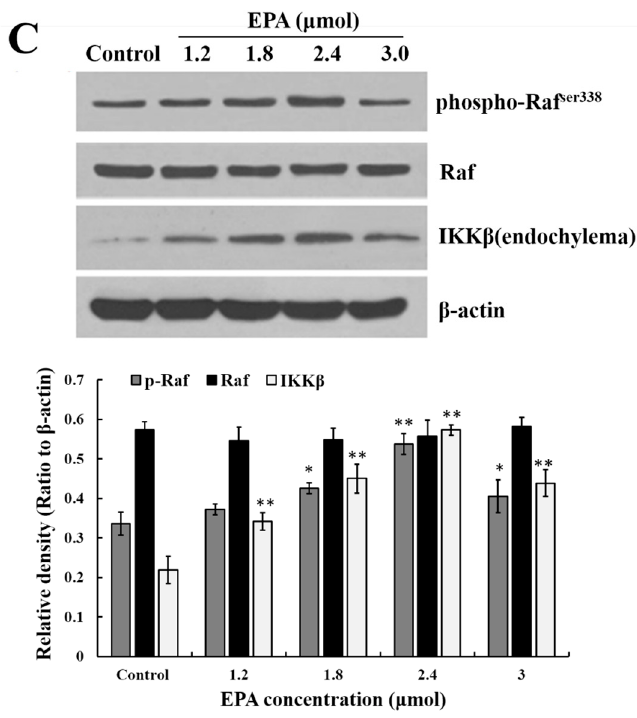
Figure 3. Measurement of GPR120, ERK, Raf and IKK β . ( A ) Effect of EPA on the protein expression of GPR120 in RAW264.7 cells; ( B ) Effect of EPA on the protein expression of ERK1/2 in RAW264.7 cells; ( C ) Effect of EPA on the protein expression of Raf and IKK β in RAW264.7 cells. Cells were treated with DMSO (equivalent volume 3.0 µ M EPA, as control) or various concentrations (1.2, 1.8, 2.4 and 3.0 µ mol) of EPA for 24 h. The expression of protein was analyzed by Western blot. The β -actin was used as an equal loading control (means ± SD, * p < 0.05 and ** p < 0.01 compared with the